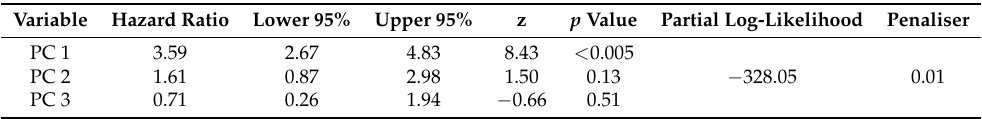
Table 1. Fitting results of the Cox PHM with time-varying covariates based on the run-to-failure records of training set